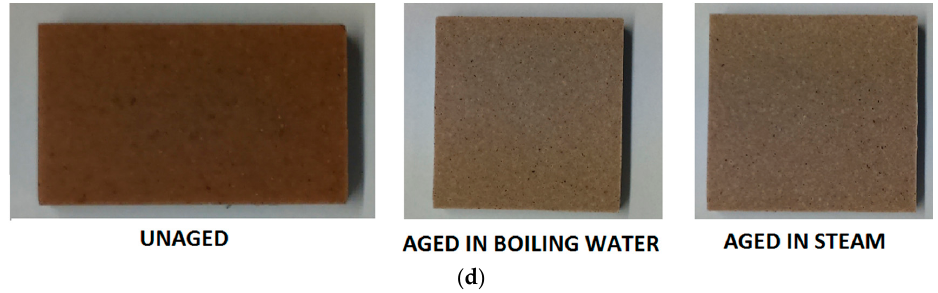
Figure 6. ( a ) Colour change due to ageing in formulation F1; ( b ) Colour change due to ageing in formulation F2; ( c ) Colour change due to ageing in formulation F3; ( d ) Colour change due to ageing in formulation F4.